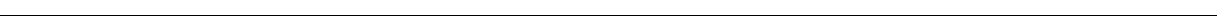
Figure 5 | Integrin activation promotes filopodia formation and calcium entry at filopodia tips. ( a , b ) MDA-MB-231 cells transiently expressing MYO10-mCherry were plated on FN, stained for active integrin (12G10 clone) ( a ) or talin-1 ( b ) and imaged using a TIRF microscope (scale bar, 20 m m). ( c ) MDA-MB-231 cells transiently expressing MYO10-GFP were plated on FN, treated with a Rap1 inhibitor (GGTI 298; 10 m M) for 1h, fixed and the number of MYO10-positive filopodia per cell was quantified ( n 4 100 cells, three biological repeats, *** P value o 1.6 (cid:3) 10 (cid:2) 14 ). ( d ) MDA-MB-231 cells previously silenced for talin-1 using two distinct siRNAs and transiently expressing MYO10-GFP were plated on FN for 2h, fixed and the number of MYO10-positive filopodia per cell was quantified ( n 4 65 cells, three biological repeats, *** P value o 1.8 (cid:3) 10 (cid:2) 24 ). ( e ) MDA-MB-231 cells transiently expressing MYO10-mCherry together with GFP or with a GFP-tagged constitutively active mutant of Rap1 (CA-Rap1) were plated on FN, treated with DMSO, felodipine or amlodipine besylate (10 m M), fixed and the number of MYO10-positive filopodia per cell was quantified ( n 4 76 cells, three biological repeats; *** P value o 4.3 (cid:3) 10 (cid:2) 6 ). ( f ) MDA-MB-231 cells transiently expressing MYO10-mCherry together with GFP or with GFP-tagged talin head were plated on FN, treated with DMSO, felodipine or amlodipine besylate (10 m M), fixed and the number of MYO10-positive filopodia per cell was quantified ( n 4 77 cells, three biological repeats; *** P value o 6.29 (cid:3) 10 (cid:2) 12 ). ( g ) MDA-MB-231 cells transiently expressing MYO10-mCherry and the calcium probe were plated on conformation-specific anti- b 1 integrin antibodies (anti-active b 1 integrin, 12G10; anti-inactive b 1 integrin, 4B4) for 2h in the presence of DMSO, felodipine or amlodipine besylate (10 m M). Representative images are displayed (scale bar, 20 m m). For each condition, the number of MYO10-positive filopodia per ( h ) Cartoon representing the sequence of events by which integrin inside-out signalling promotes calcium entry at filopodia tips, via L-type calcium channels, and subsequent filopodia stability. P values were calculated using Student’s t -test (unpaired, two-tailed, unequal